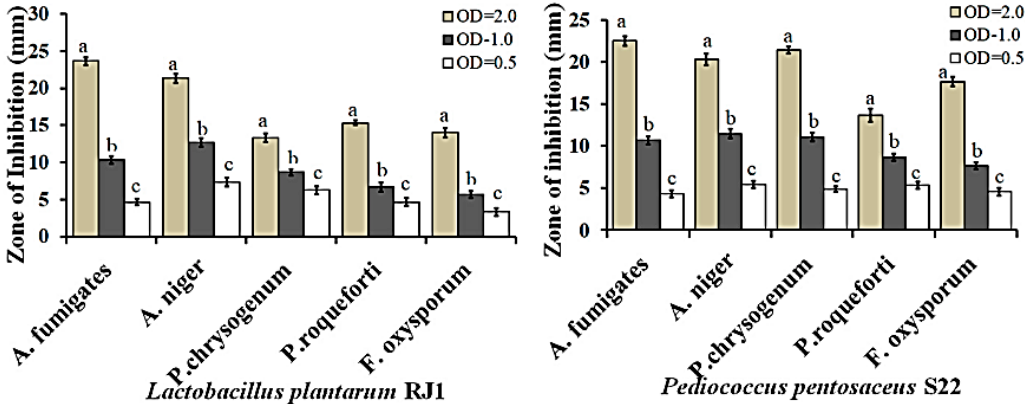
Figure 3. Antifungal activity of the selected LAB cultures at different concentrations (OD: 0.5, 1.0, and 2.0). Inhibitory activity of L. plantarum RJ1 and P. pentosaceus S22 was tested against five fungal targets. The results are expressed as the mean values of three replicates ( n = 3) and data were analyzed by one-way ANOVA with Duncan’s multiple comparison test. Different letters (a, b, c) denote statistically significant differences between the various concentration of LAB strains (OD: 0.5, 1.0, and 2.0) against the selected fungal cultures ( p < 0.05).